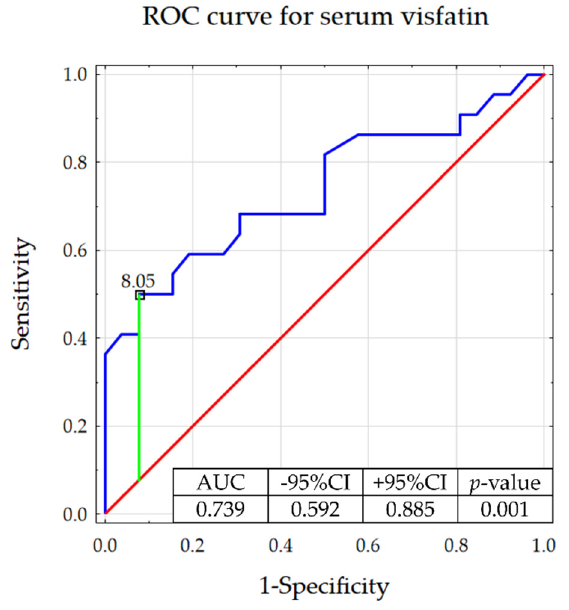
Figure 2. Receiver operating characteristic curve determining the potential of serum visfatin to discriminate between adrenocortical carcinomas and benign adrenocortical tumors (with presented proposed cut-off based on the Youden’s index).